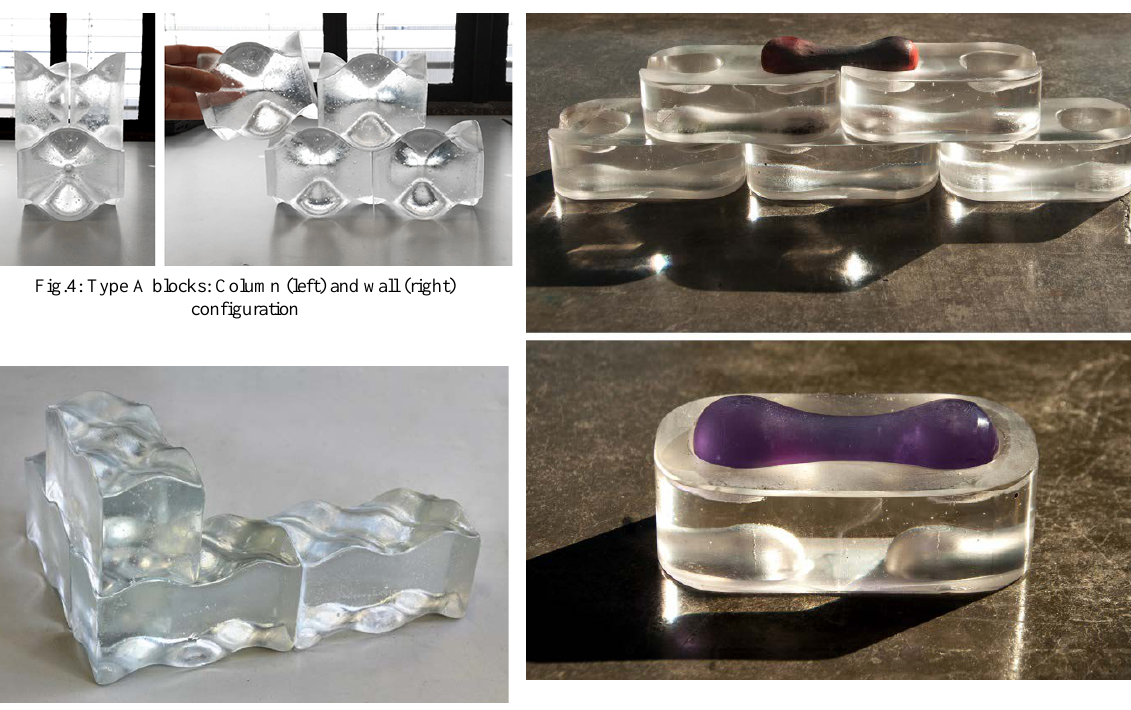
Fig.5: Type B blocks: Corner configuration Fig.6: Type C blocks: Wall configuration. Colored (dichroic) glass has been used for the bone-shaped elements.